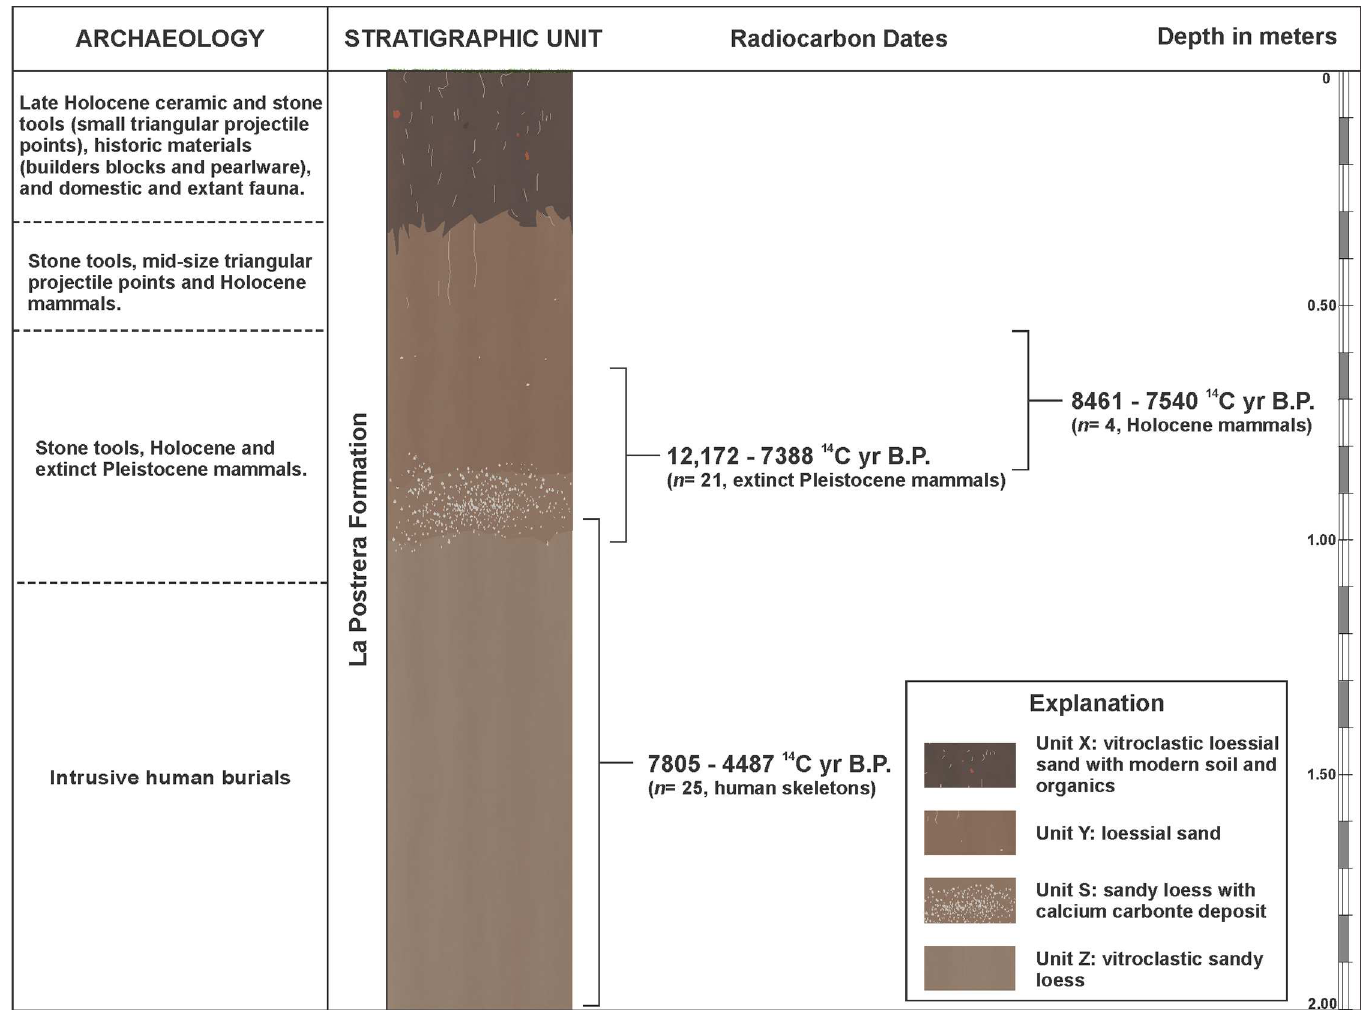
Fig 2. Generalized stratigraphicprofileof the AS2